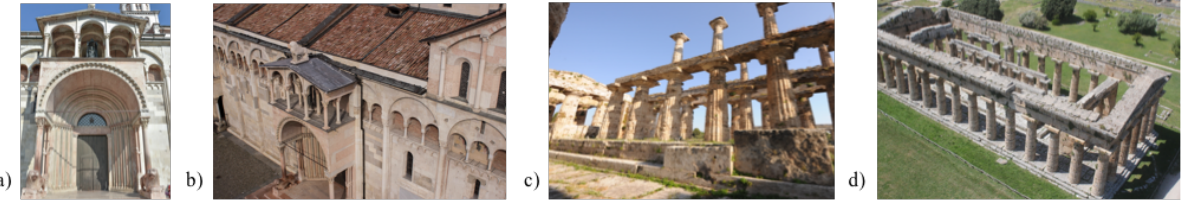
Figure 1: Examples of datasets acquired with heterogeneous sensors: the Modena Cathedral (left) and the Neptune Temple in Paestum (right) as seen from terrestrial (a, c) and from UAV (b, d) images acquired for 3D documentation